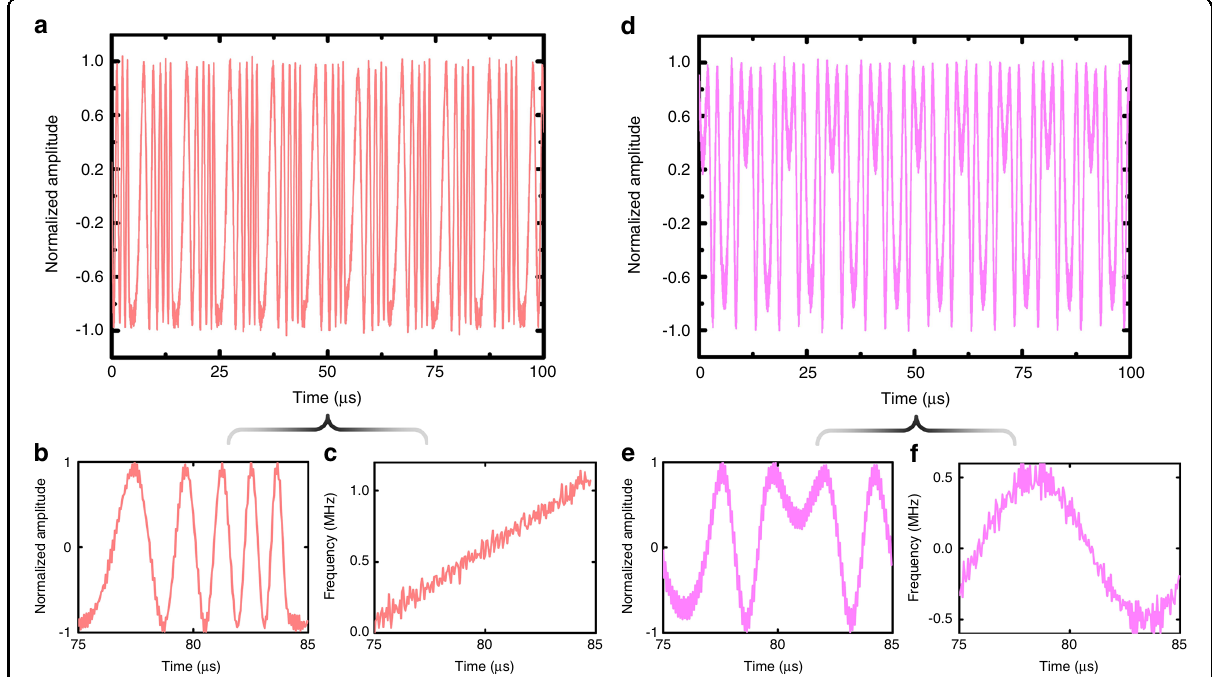
Fig. 5 Measured results of the linear and sinusoidal FMCWs. a – c The measured baseband FMCW waveforms in ten periods ( a ) and one period ( b ), and the corresponding baseband time-frequency curve ( c ) for the linear FMCW. d – f The measured baseband FMCW waveforms in ten periods ( d ) and one period ( e ), and the corresponding baseband time-frequency curve ( f ) for the sinusoidal